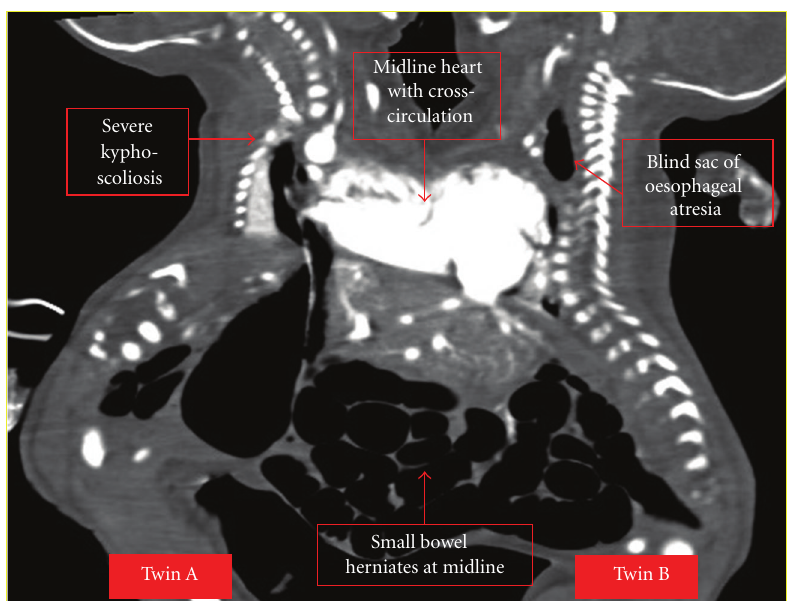
Figure 2: Virtual Reality reconstruction of twins A and B.